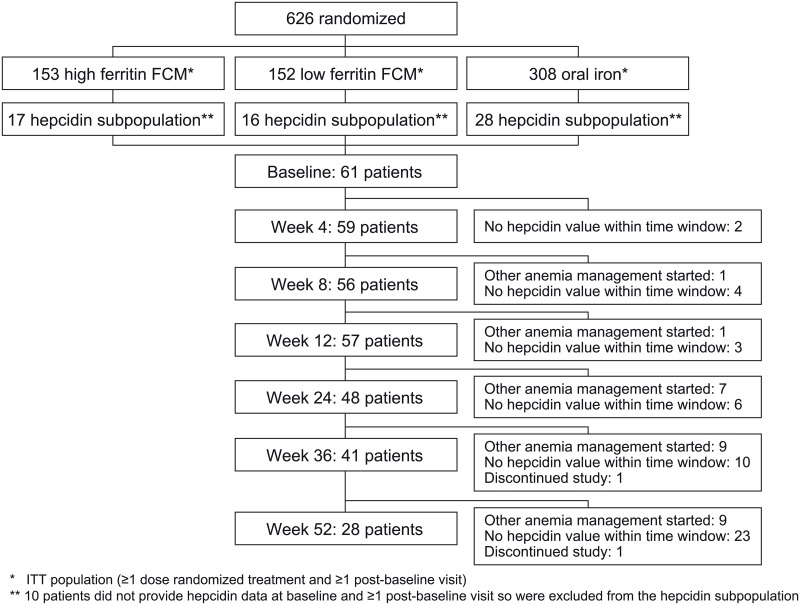
Patient disposition (hepcidin subpopulation).Disposition according to treatment group is shown in S1 Table.